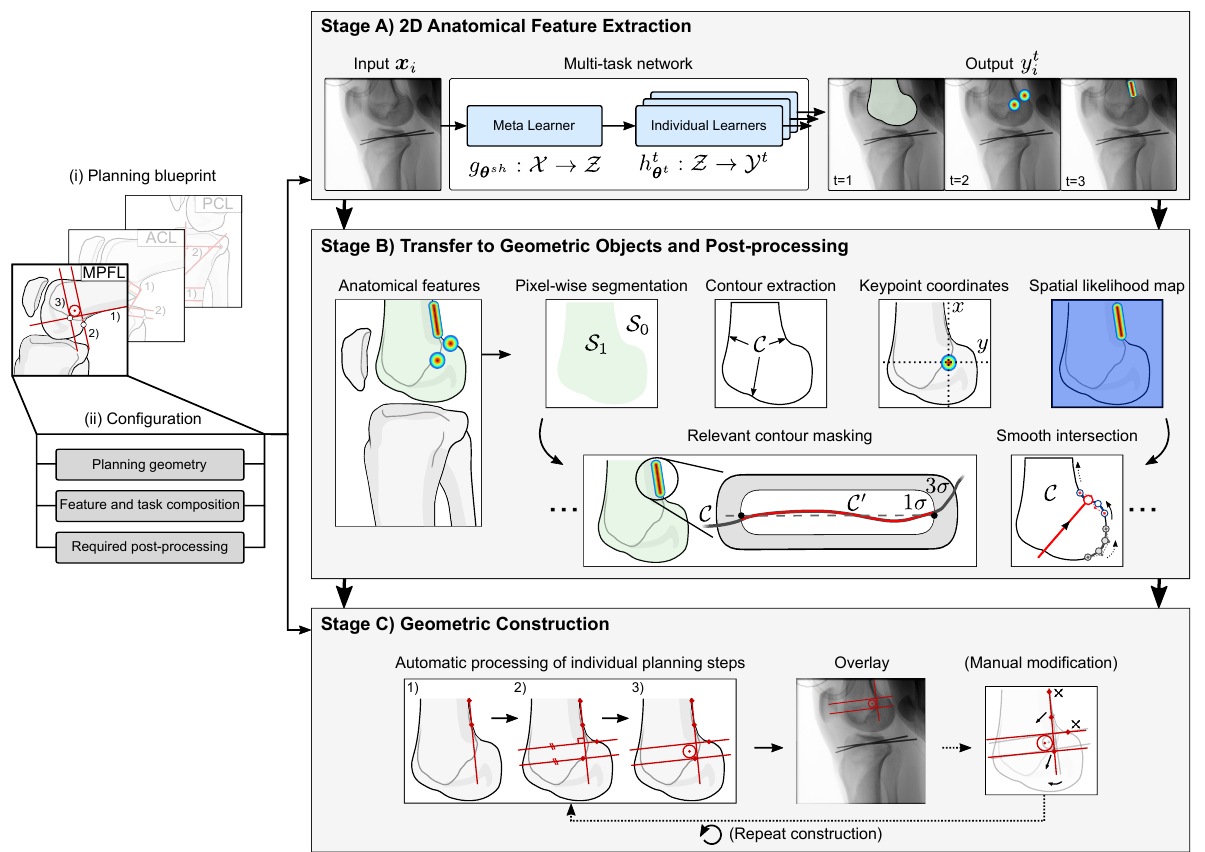
Figure 2. Overview of the automatic planning workflow. After selecting a planning blueprint and a corresponding configuration, the target X-ray image is processed in three consecutive stages. After extraction the 2D anatomical features with a multi-task network, they are transformed to their corresponding geometric descriptors. The individual construction steps defined in the planning blueprint are automatically calculated by interrelating the extracted geometry (here, steps 1–3 in Stage C)). If needed, the user can manually modify the planning by adjusting individual control points upon real-time updates of the complete